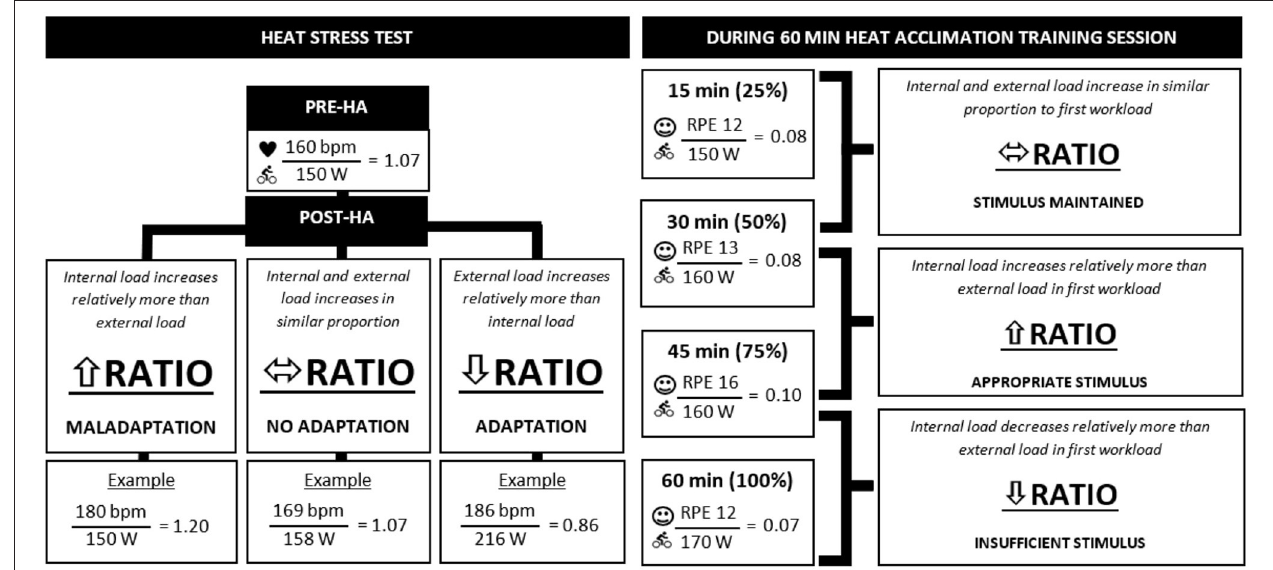
FIGURE 1 | Hypothetical example of applying an internal-to-external load ratio for assessing self-paced heat stress tests and heat acclimation (HA) training sessions. = mean heart rate, = mean power output, = rating of perceived